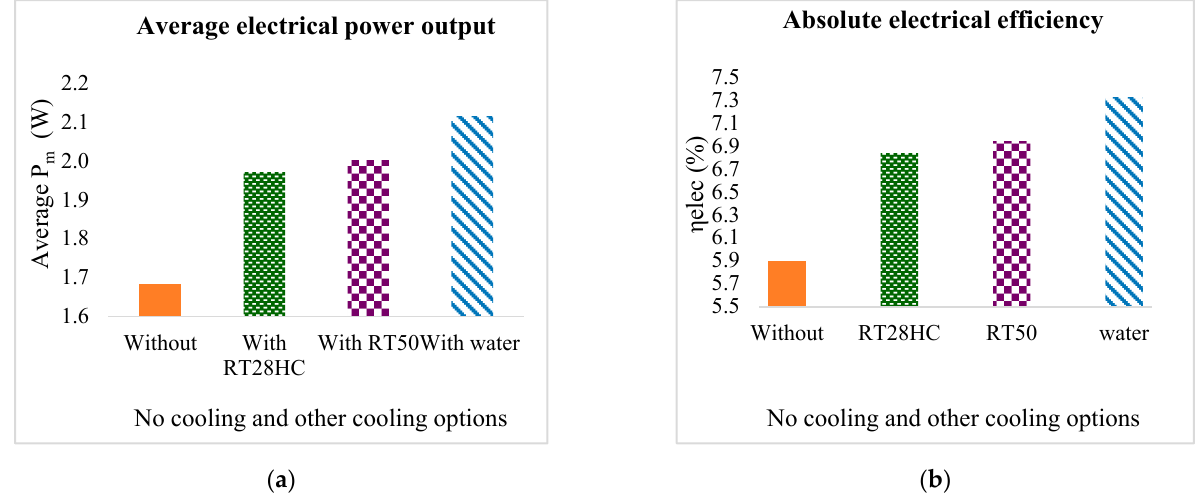
Figure 5. Comparison of the ( a ) average P m and ( b ) absolute electrical efficiency with natural ventilation and with the use of sensible (water) and latent (PCM) cooling.